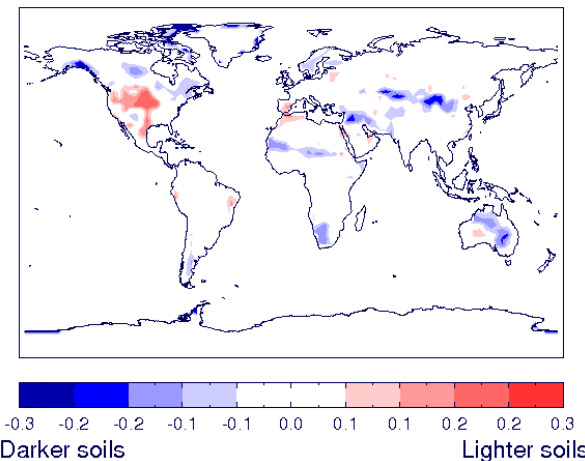
Fig. 3. The changes in soil albedo between the PRISM3 control ex- Figure 3. The changes in soil albedo between the PRISM3 control experiment and the new 833 periment and the new late Pliocene soils reconstruction. Differences Late Pliocene soils reconstruction. Differences in other soil components can be found in 834 in other soil components can be found in Supplement Supplementary Information 2. 835